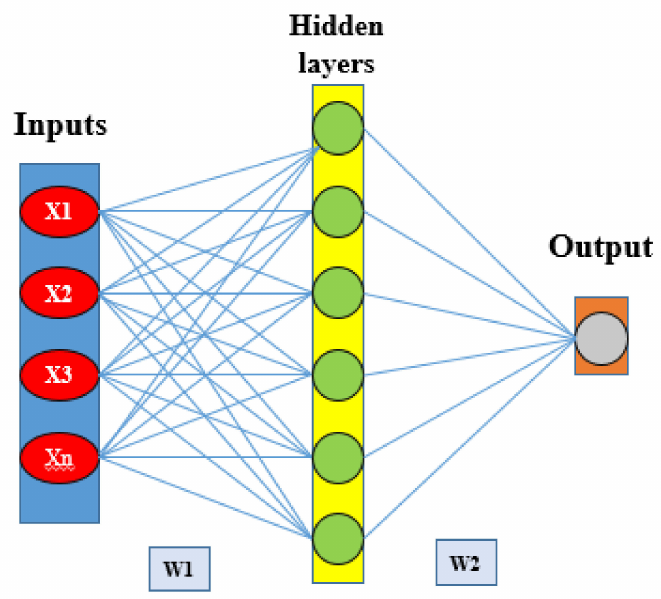
Figure 5. Schematic of feed-forward artificial neural